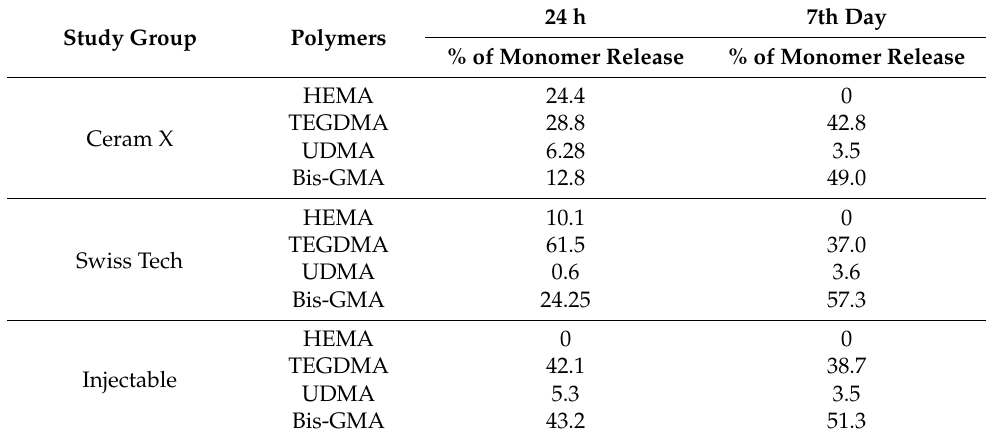
Table 2. Monomer elution from three resins composite at different time